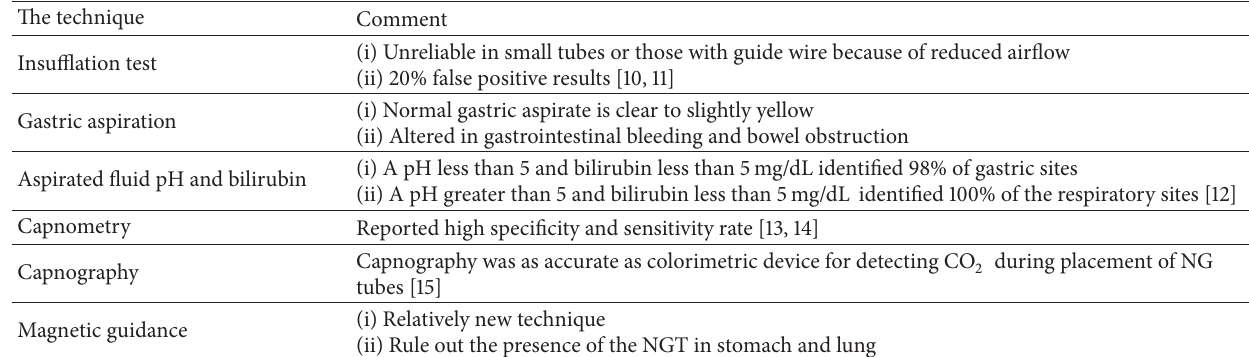
Table 3: Techniques used to confirm NG